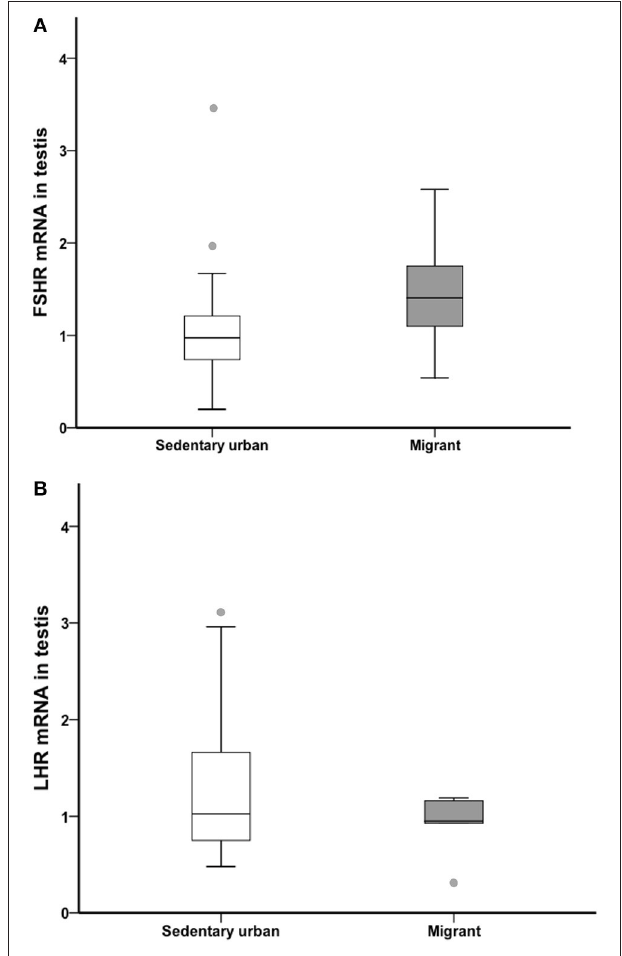
FIGURE 5 | Male sedentary urban juncos (white boxes) and migrant juncos (gray boxes) did not differ in plasma corticosterone at any point during the study (A) . Male migrant juncos exhibited larger subcutaneous fat scores than urban male juncos (B) (* p ≤ 0.05; ** p ≤ 0.01). The samples were collected on the following dates: 1 = 26 & 27 February, 2 = 5 & 6 March, 3 = 12 & 13 March, 4 = 19 & 20 March. Boxes represent upper quartile, median, and lower